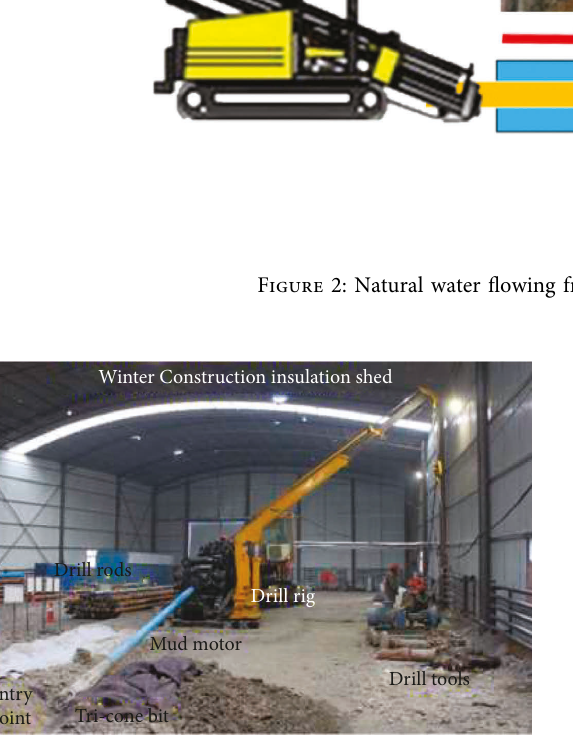
Figure 3: Geological survey site of the horizontal directional drilling